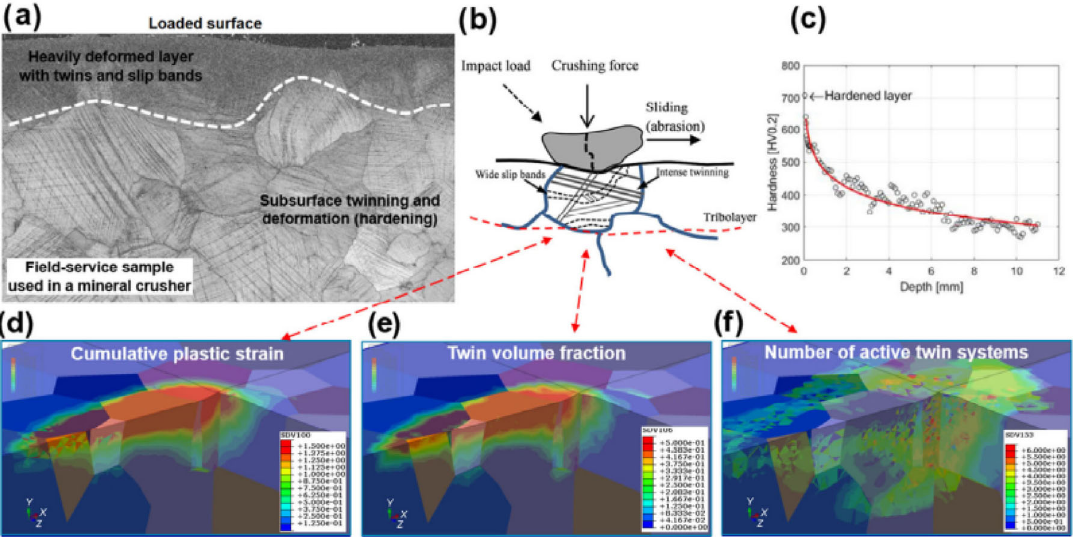
Fig. 76 Simulation results from micromechanical modelling of polycrystalline high manganese austenitic steel subjected to abrasive contact. (a) Cross-section of field-service sample; (b) schematic of surface deformation; (c) cross-section hardness gradient; (d) cumulative plastic strain; (e) twin volume fraction; and (f) number of currently active twin systems [929]. Reproduced with permission from Ref.